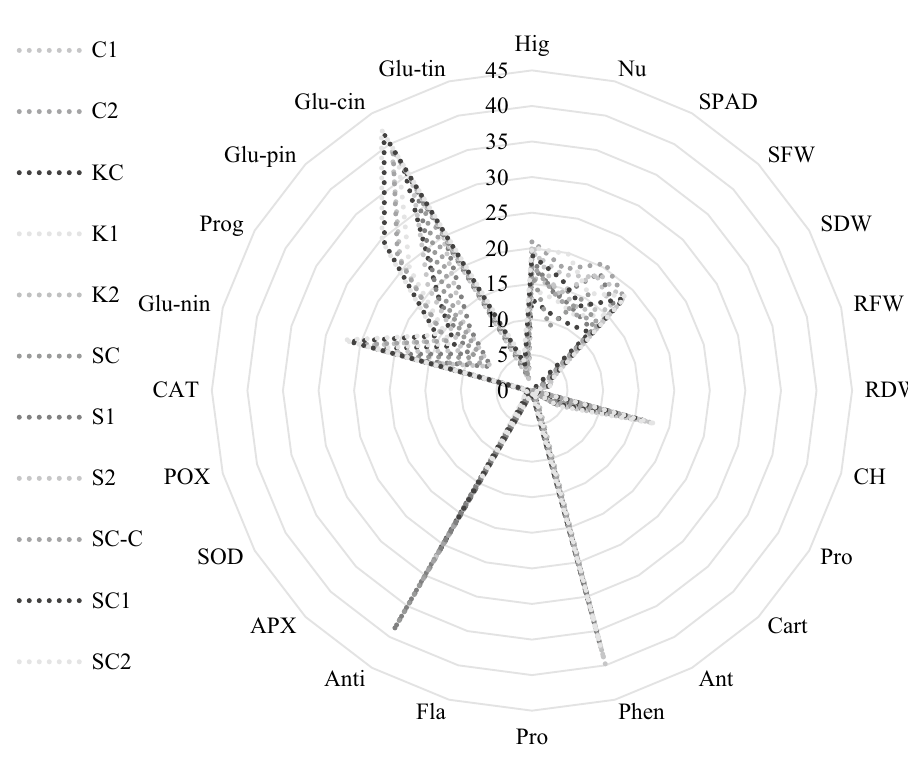
Figure 5. The interaction effect of AA and cabbage cultivars on all vegetative and nutritional traits. Collard & 0 mg/L amino acid (CC), Collard & 150 mg/L amino acid (C1), Collard & 300 mg/L amino acid (C2), Ka-red & 0 mg/L amino acid (KC), Ka-red & 150 mg/L amino acid (K1), Ka-red & 300 mg/L amino acid (K2), Ka-smooth & 0 mg/L amino acid (SC), Ka-smooth & 150 mg/L amino acid (S1), Ka-smooth & 300 mg/L amino acid